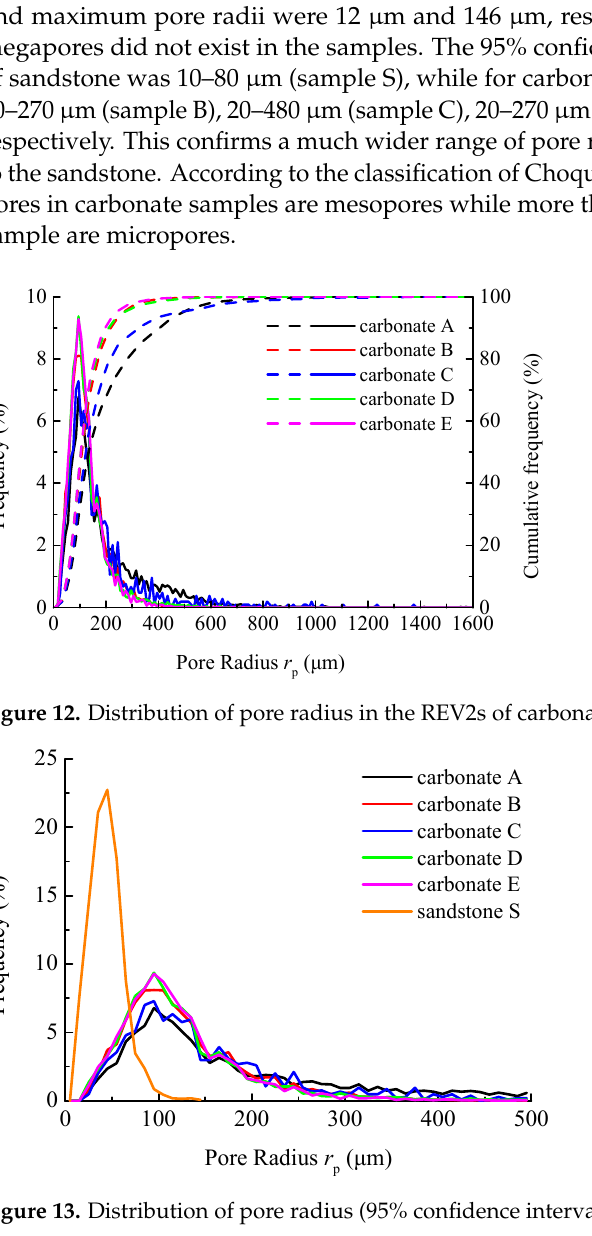
Figure 13. Distribution of pore radius (95% confidence interval).